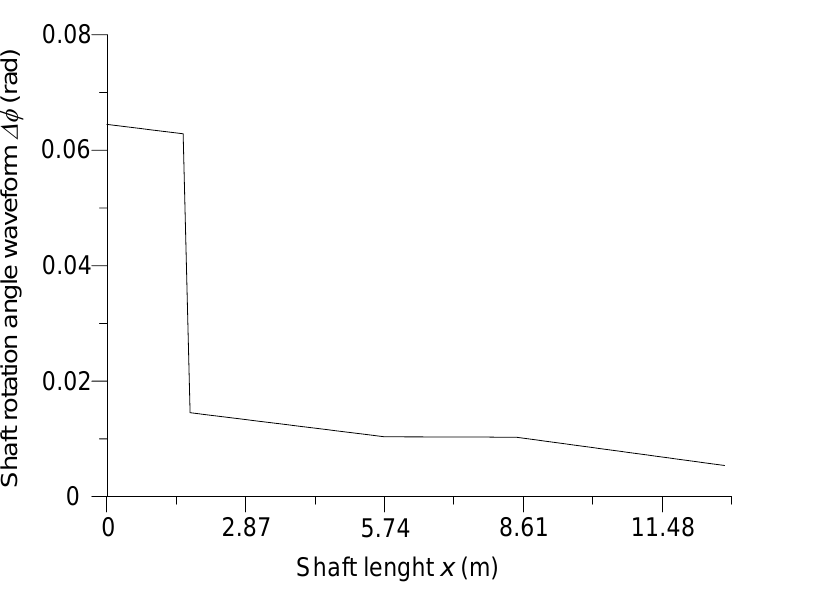
Figure 13. Angle of rotation of the long drive shaft as a function of the shaft length during a three- phase symmetrical short circuit for t = 15.1 s. 4. Conclusions Mathematical modeling of transient processes in complex rotating systems that con- tain long elastic elements can be carried out on the basis of general equations of motion that describe physical processes in a mechanical system with distributed parameters. Con- trary to the general Lagrange theory relating to a system with lumped parameters, the method proposed in the paper makes it possible to take into account the movement of a mechanical wave along a drive shaft. This approach with the use of mechanical field the- ory describes at a higher level of adequacy the dynamic processes in motion transmissions in propulsion systems with shaft generators on ships. For the analysis of transient processes in a ship’s shaft generators, mathematical mod- els of electrical machines in phase coordinates can be used, which in the general case